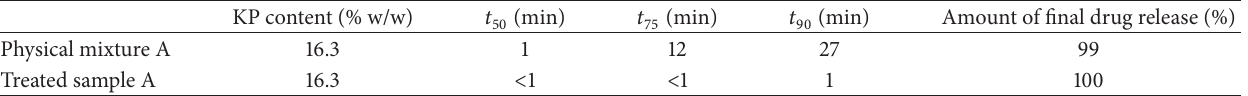
Table 4: Indices to compare the release performance of powders of the physical mixtures and treated samples (pH = 2).